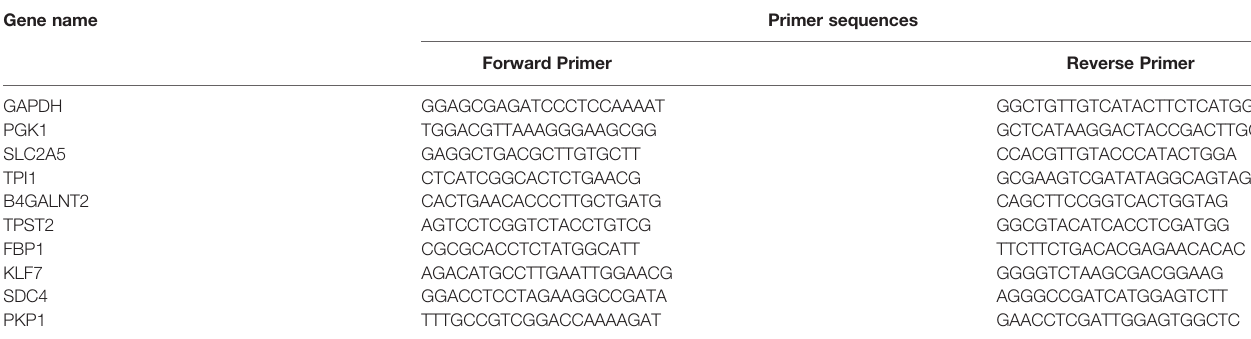
TABLE 1 | The primers of 10 selected hypoxia